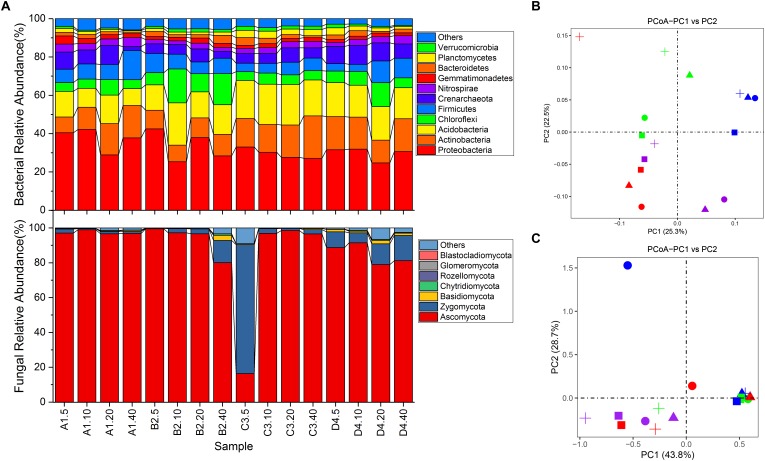
Differences in microbial community structures and compositions. (A) relative abundance of microbial community composition characterized to the phylum level (top 10 taxa). (B) principle coordination analysis (PCoA) of bacterial community among all soil samples. (C) PCoA of fungal community among all soil samples. Shapes in circle, triangle, square and cross represent samples from site A, B, C and D, respectively. Shapes in color red, green, blue and purple represent samples from 0 to 5 cm, 5 to 10 cm, 10 to 20 cm and 20 to 40 cm, respectively.